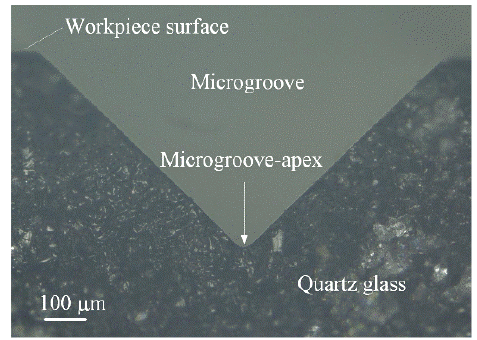
Figure 5. The microgroove profile of quartz glass after micro-grinding.